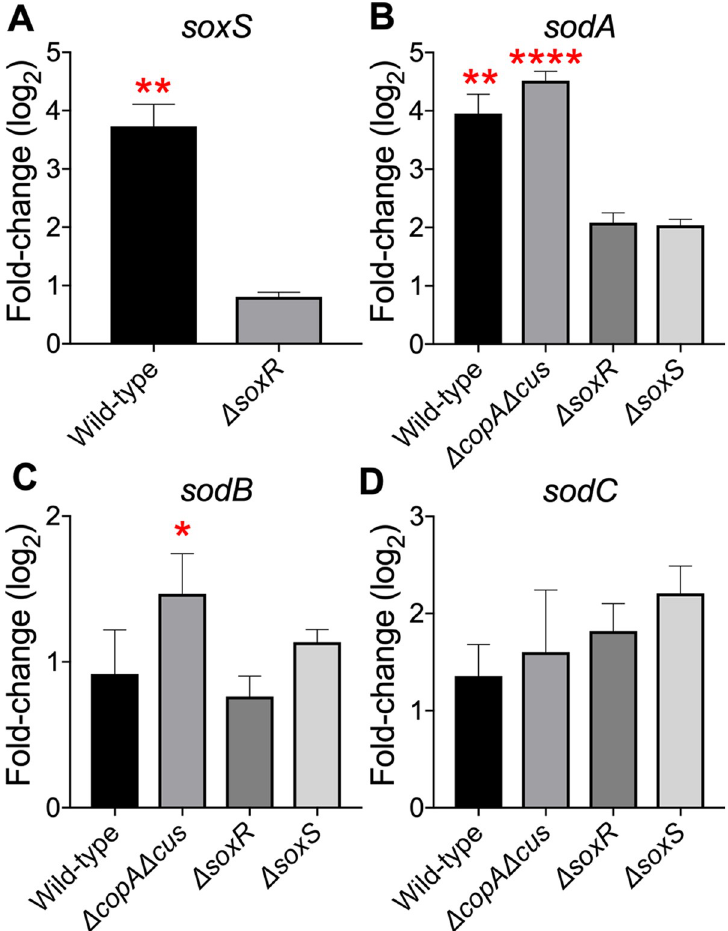
Fig 4. Expression of sod genes during sublethal copper stress. Wild-type UPEC strain CFT073, Δ copA Δ cus , Δ soxR , and Δ soxS mutants were grown in LB with or without copper. Real-time PCR was used to quantify soxS (A), sodA (B), sodB (C), sodC (D) transcript levels. Relative expression, compared to no copper control, was calculated after normalizing to gapA transcript. Bars correspond to mean + SEM from 3 independent experiments. � P < 0 . 05 , �� P < 0 . 01 and ���� P < 0 . 0001 , ANOVA with Dunnett’s multiple comparisons